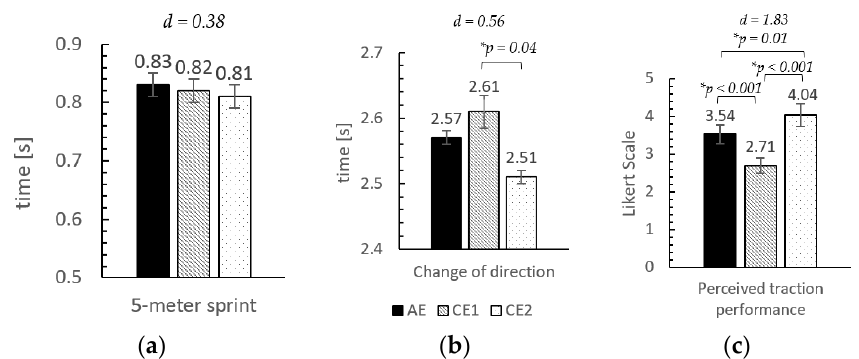
Figure 2. ( a ) 5-m sprint performance ( b ) change of direction performance ( c ) perceived overall traction performance. (*One-way ANOVA repeated measures with Bonferroni test: p < 0.05). Effect sizes are shown as Cohen’s d